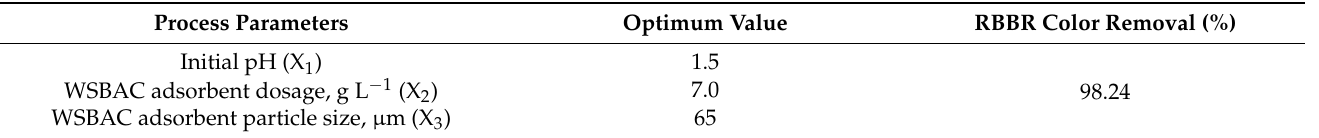
Table 6. Optimal values of the process independent variables for maximum % color removal of